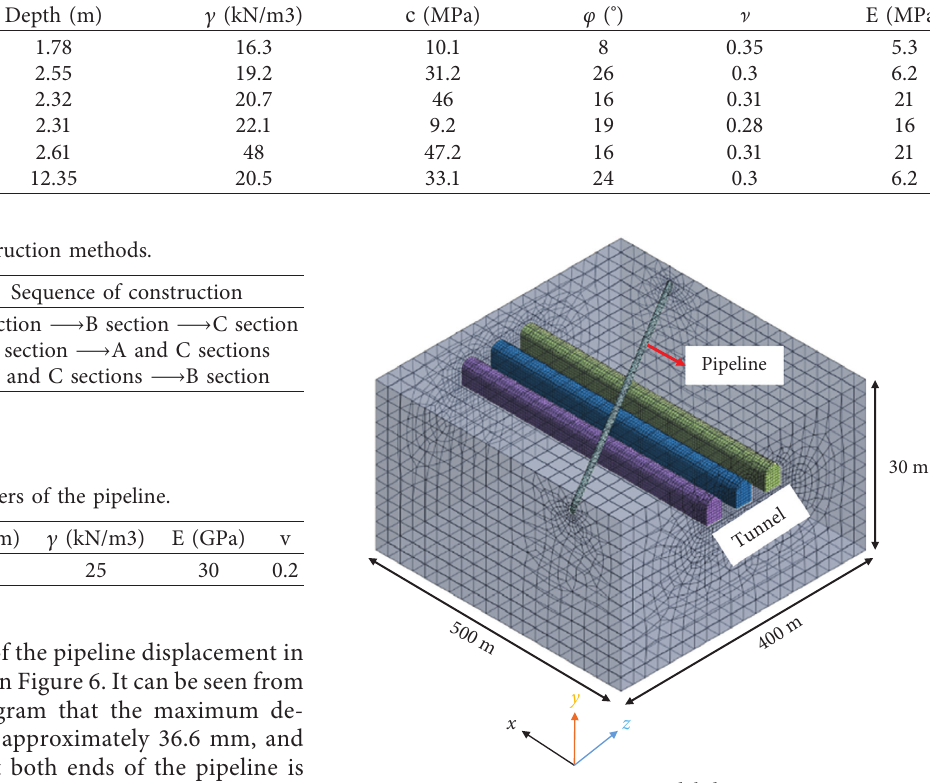
Figure 3: 3D model